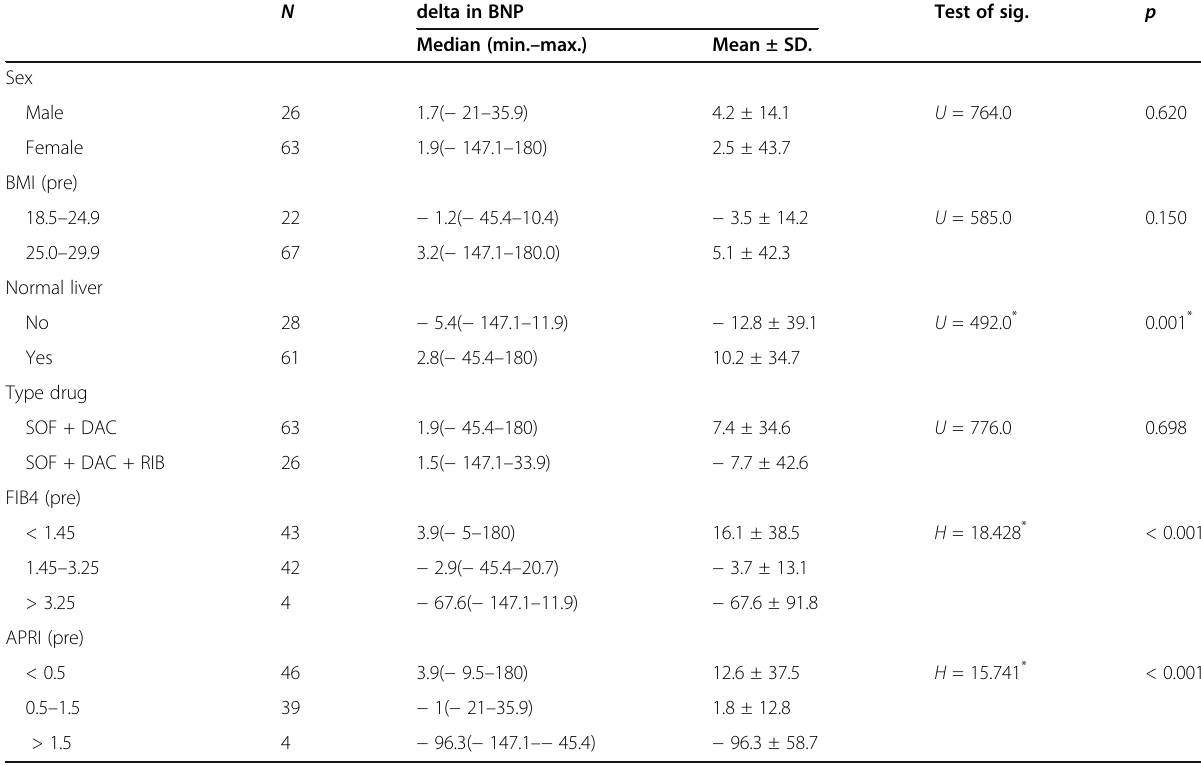
Table 5 Relation between delta BNP and different parameters N delta in BNP Test of